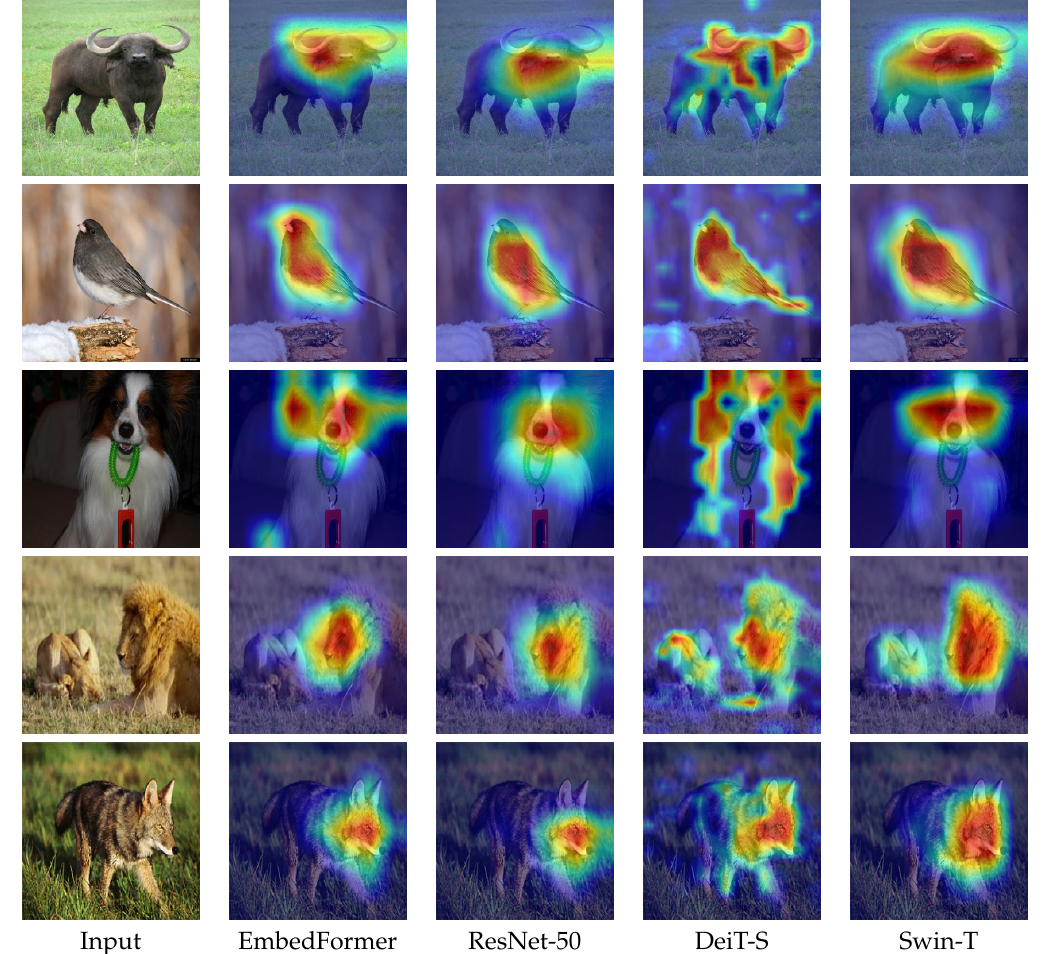
Figure 8. The Grad-CAM activation maps of the models trained on